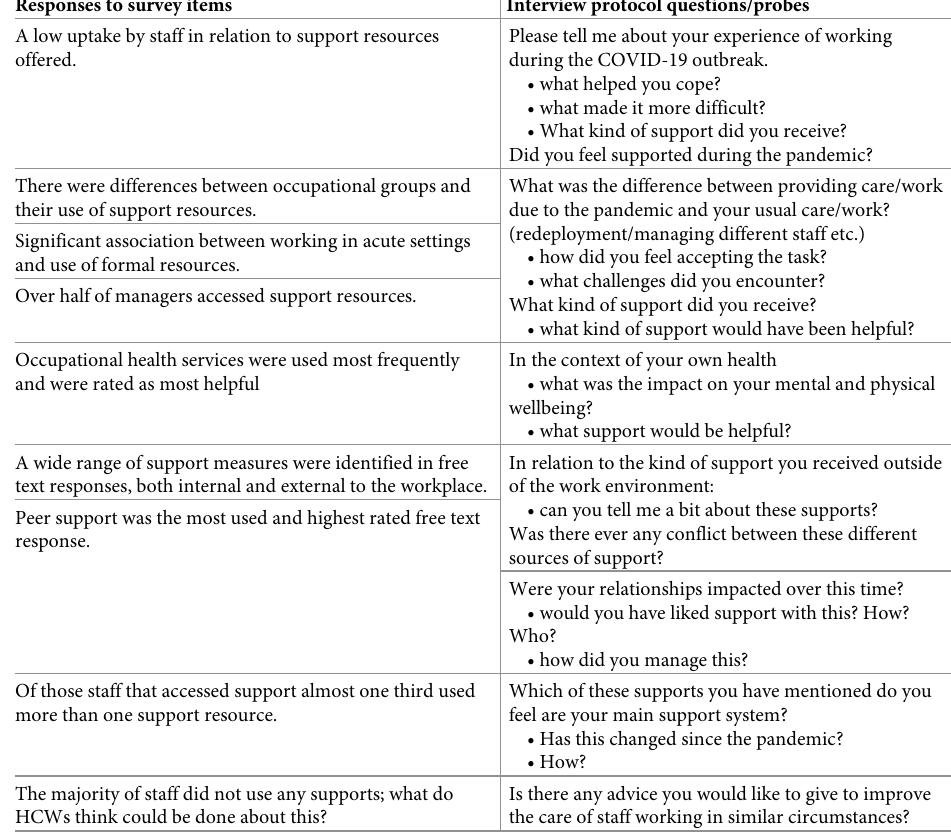
Table 1. Interview questions and probes arising from survey item